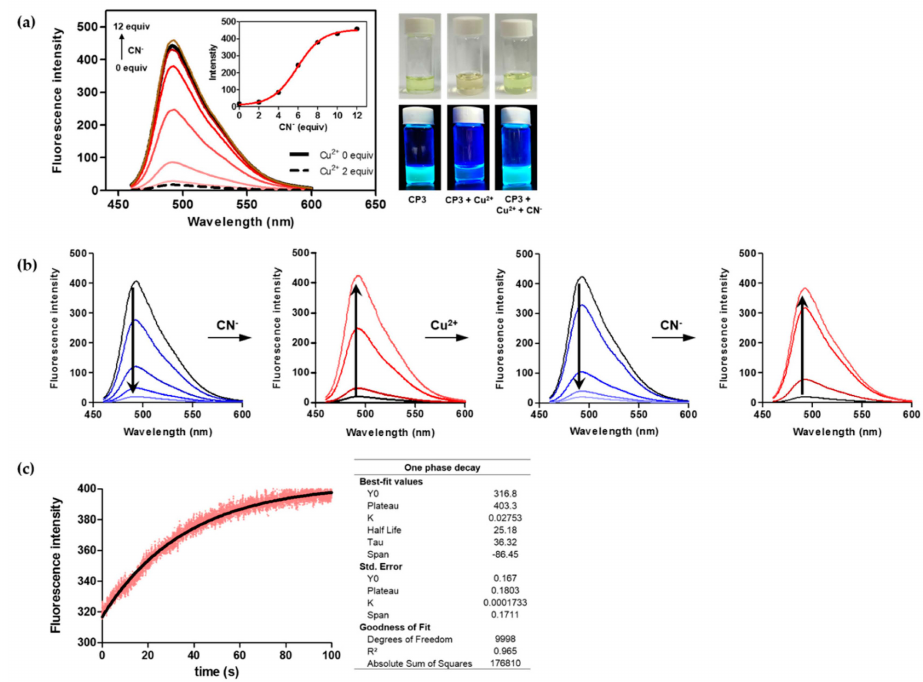
Figure 5. Fluorescence response of CP3 -Cu 2+ to CN ´ . ( a ) Emission increase upon addition of CN ´ (0 to 12 µ M) to CP3 -Cu 2+ (1 µ M) in DMSO ( λ ex = 441 nm). Insert : changes in fluorescence intensity of the solution measured at 492 nm; ( b ) rapid and reversible ON/OFF switching property of CP3 -Cu 2+ (1 µ M) with CN ´ (0 to 12 µ M) in DMSO; and ( c ) measurement of the time course for the cyanide detection by CP3 -Cu 2+ (1 µ M) as monitored by fluorescence increase in DMSO. The black line represents the fit of the data.